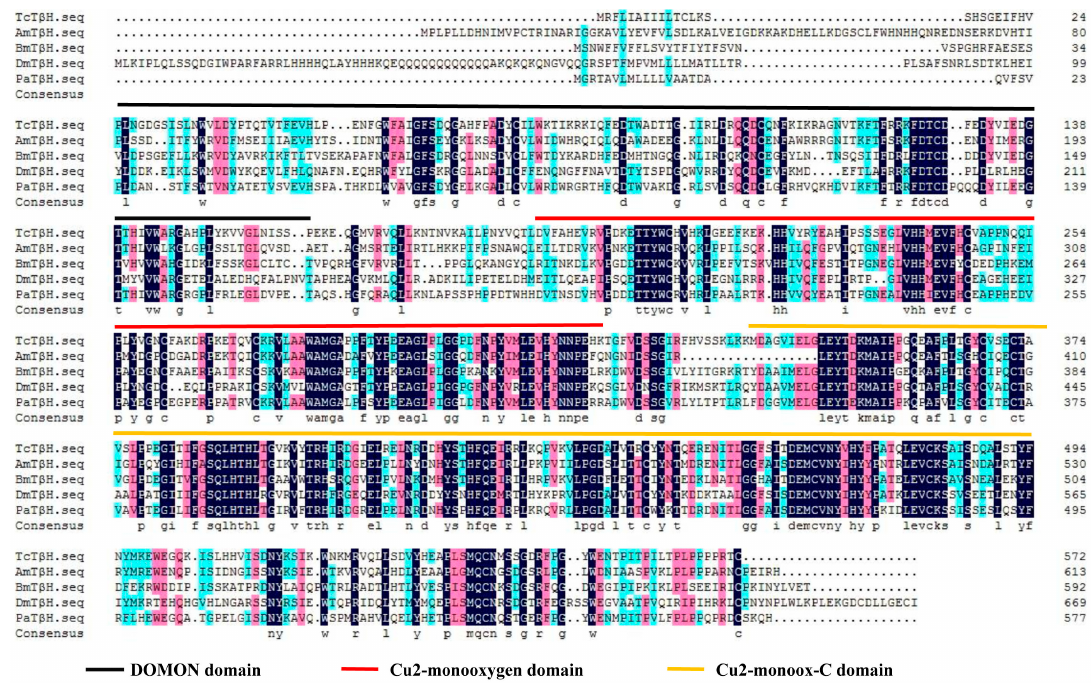
Figure 1. Multiple sequence alignment of TcT β H from four insect species: Apis mellifera (AmT β H), Drosophila melanogaster (DmT β H), Bombyx mori (BmT β H) and Periplaneta americana (PaT β H), by DNAMAN. The three different color lines represent the conserved domains, the black line is the DOMON domain, the red line the Cu2-monooxygen domain and the yellow line the Cu2-monoox-C domain. The information on T β H in these species is listed in Table S2.